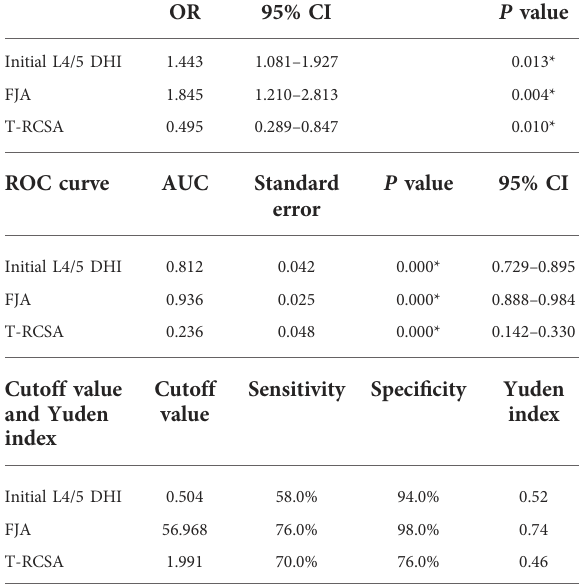
TABLE 5 Logistic regression analysis between 2 groups.